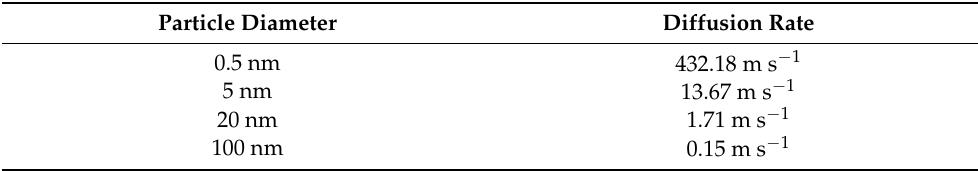
Table 4. Diffusion rate for spheres with different diameters and a density of 1 g cm − 3